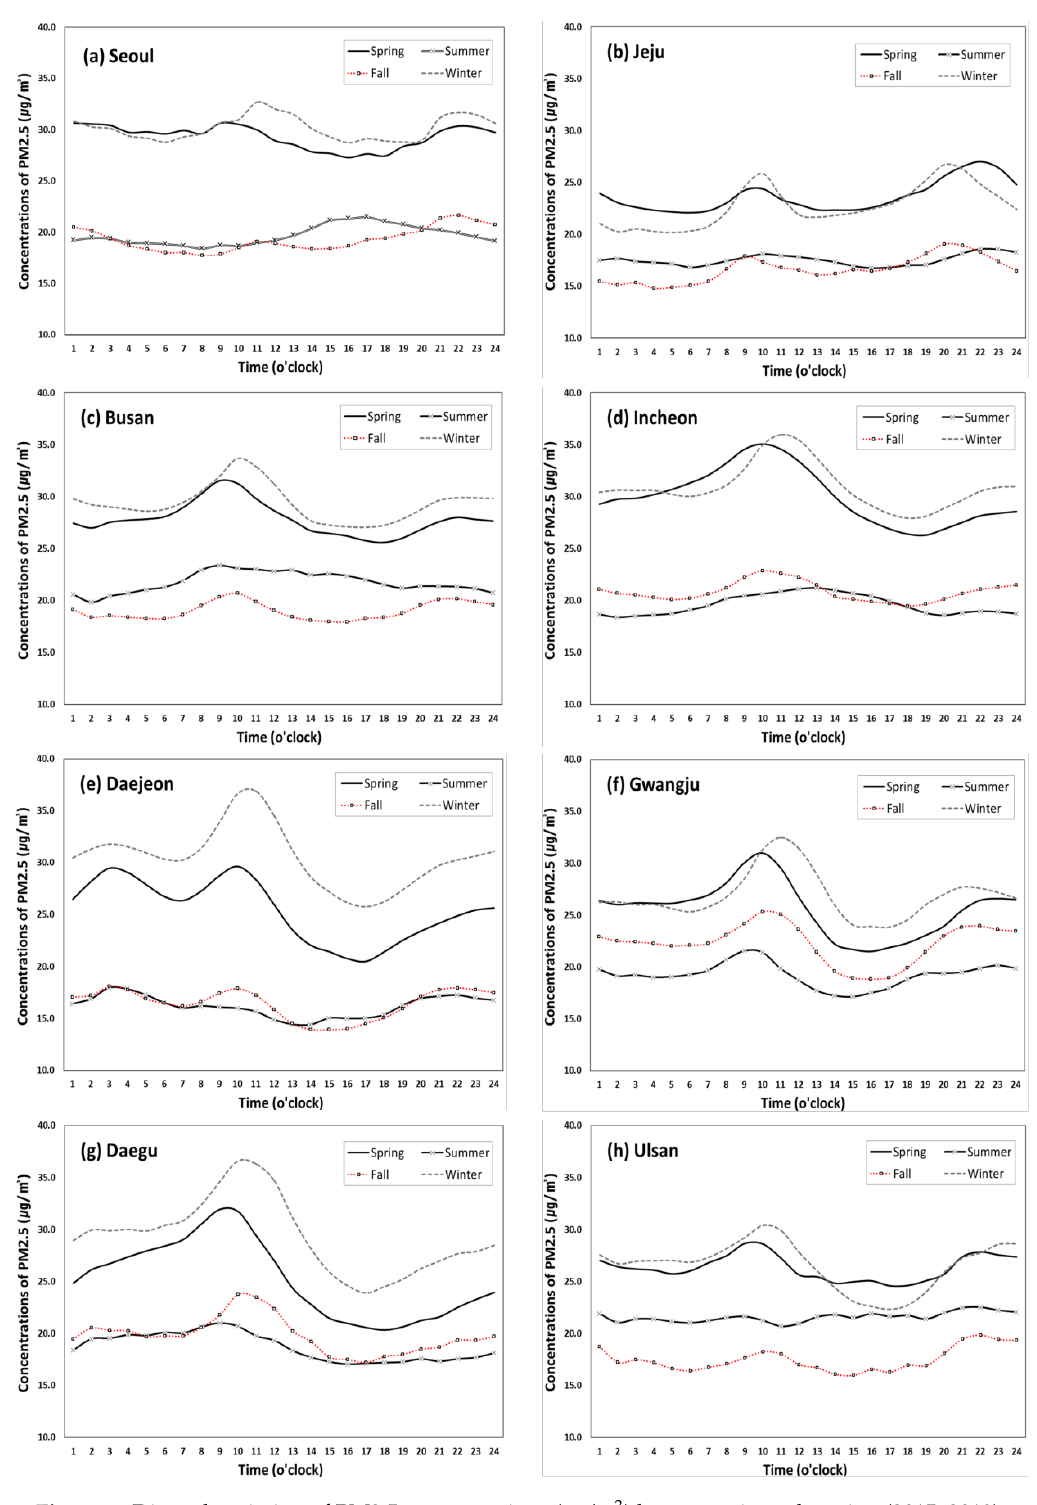
Figure 5. Diurnal variation of PM2.5 concentrations (µg/m 3 ) by season in each region (2015–2019).